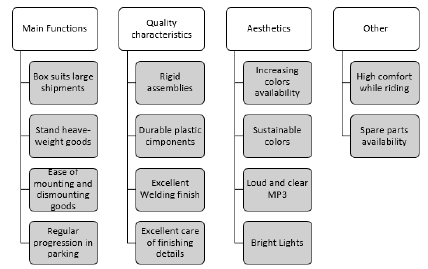
Figure 3. Affinity diagram, the result of JK method